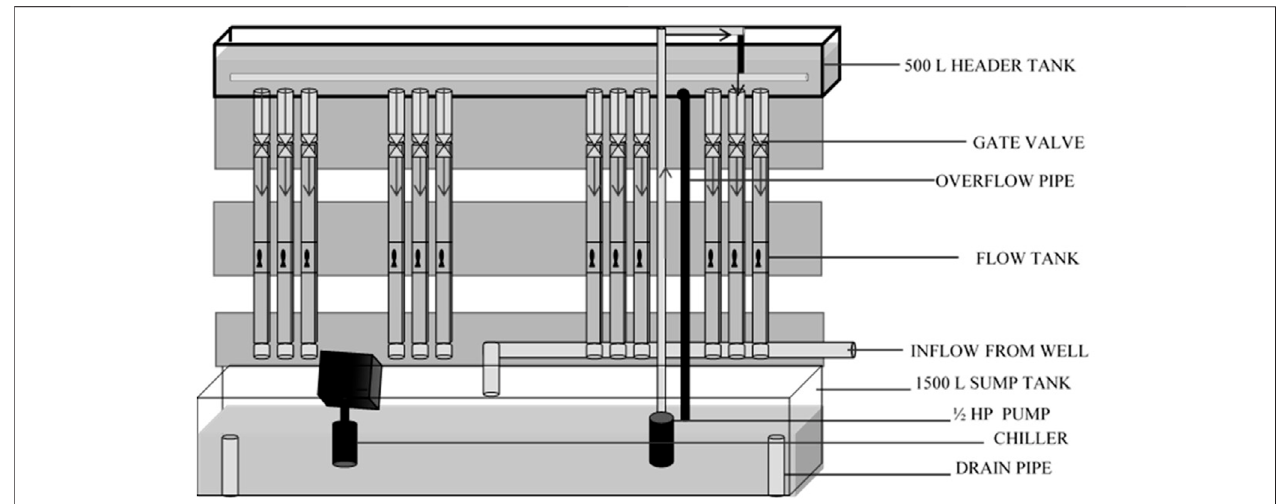
FIGURE 1 | Schematic of experimental